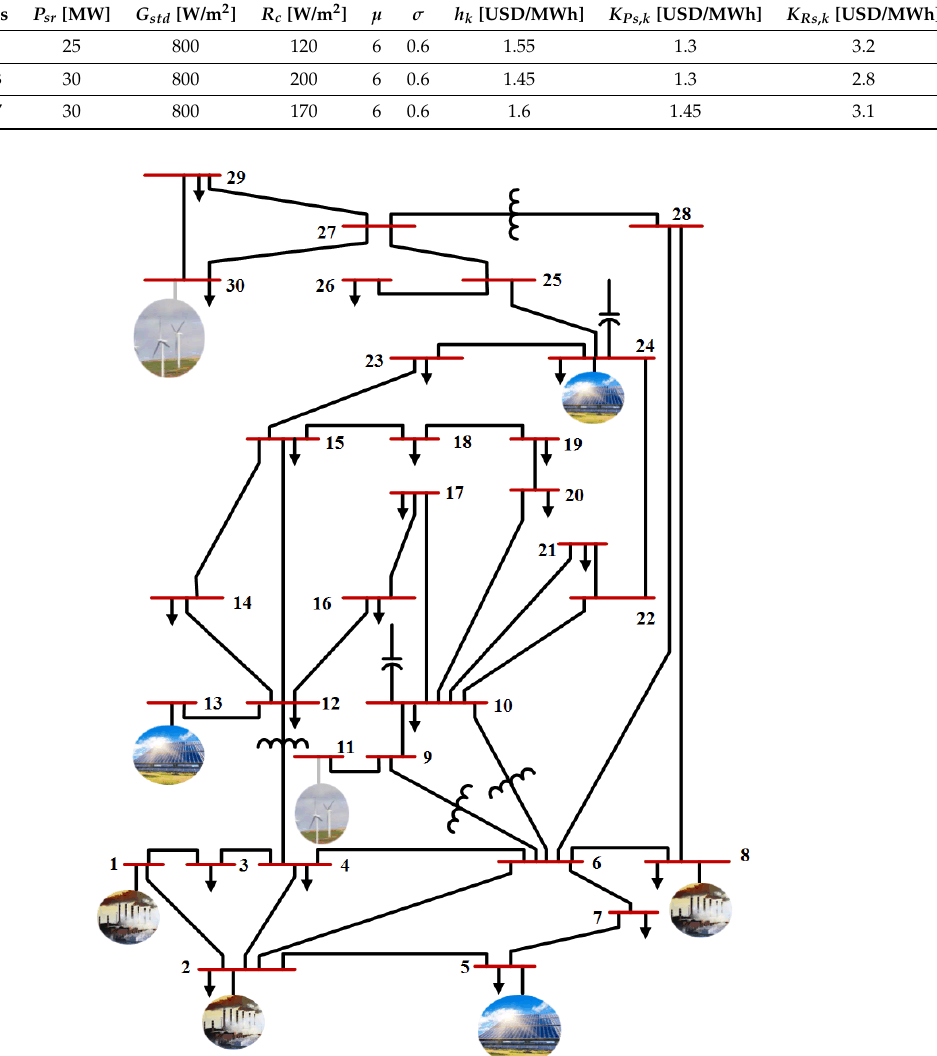
Figure A1. Scenario 2: IEEE 30-bus Modified